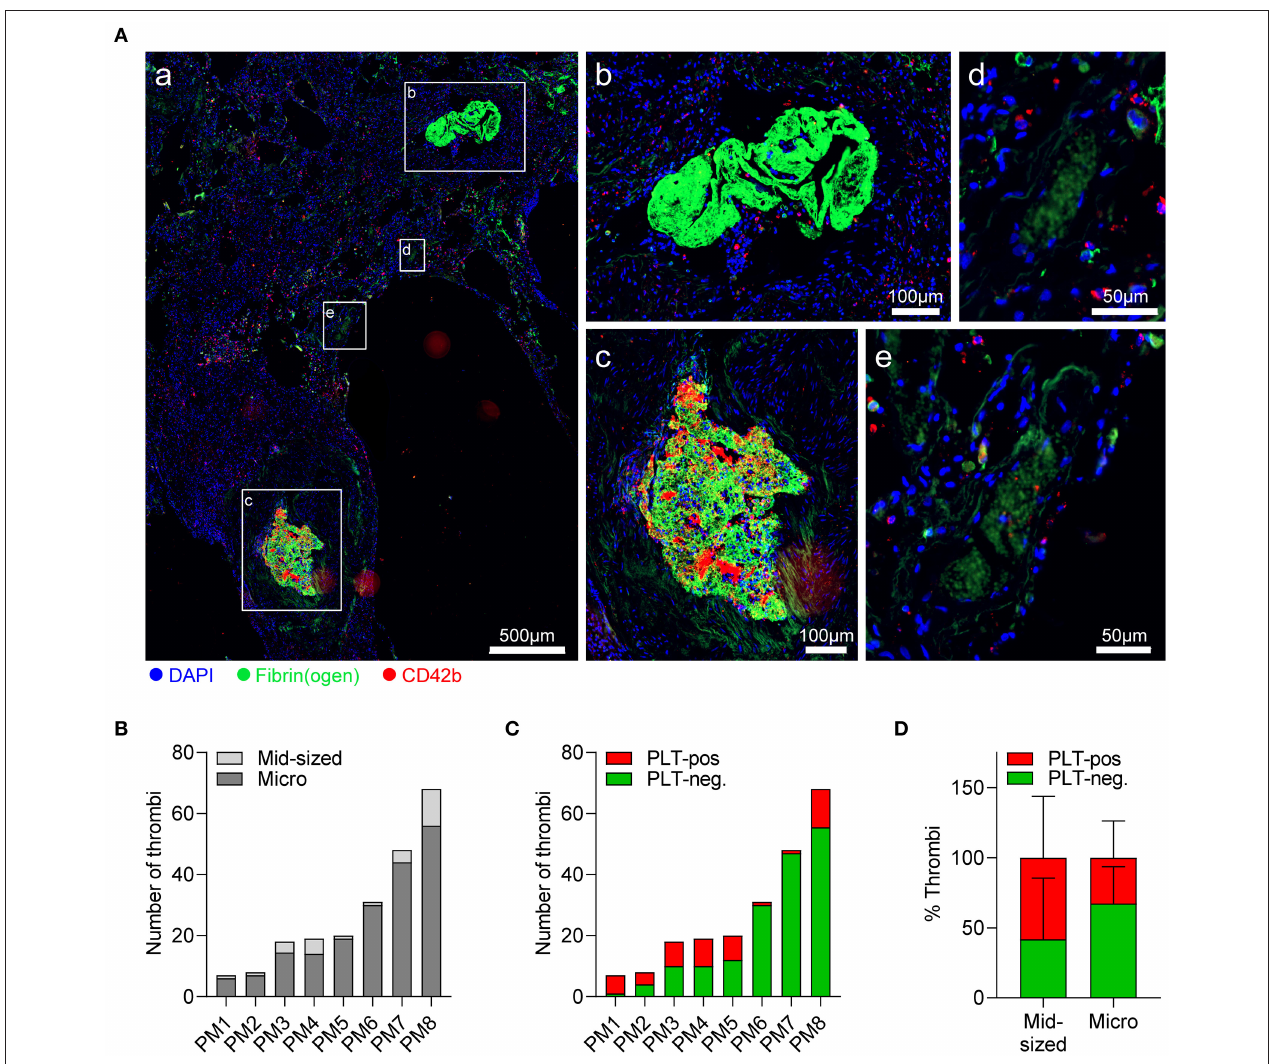
FIGURE 3 | Pulmonary thrombi in COVID-19 are platelet-poor but platelets from severe COVID-19 cases show normal spreading on fibrinogen. Postmortem lung biopsies of 8 patients with COVID-19 were stained for CD42b (red), fibrin(ogen) (green), and DAPI (blue). (A) Representative (a) overview of lung sections showing (b) platelet-negative and (c) platelet-positive mid-sized thrombi ( ≥ 500 µ m), and (d) platelet-negative and (e) platelet-positive microthrombi ( < 500 µ m). (B,C) Thrombi in individual sections were stratified according to (B) size into mid-sized thrombi ( ≥ 500 µ m) and microthrombi ( < 500 µ m) or (C) according to platelet content into platelet-positive or platelet-negative. (D) Percentage of platelet-negative and platelet-positive thrombi among mid-sized and microthrombi. Differences in platelet composition between mid-sized and microthrombi were tested by two-way ANOVA. n = 8